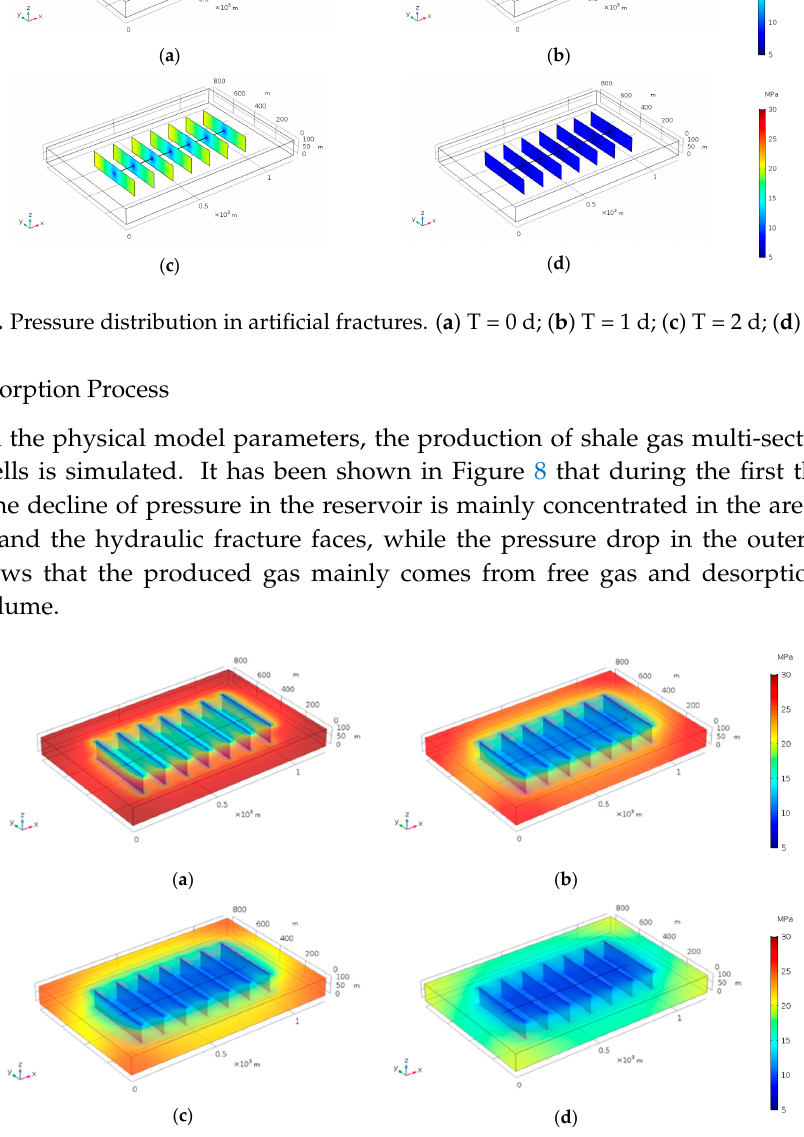
( b ) Figure 9. Influence of gas desorption on horizontal well productivity. ( a ) Average reservoir pressure at different Langmuir volumes; ( b ) Gas production rate and cumulative gas production at different Langmuir volumes.